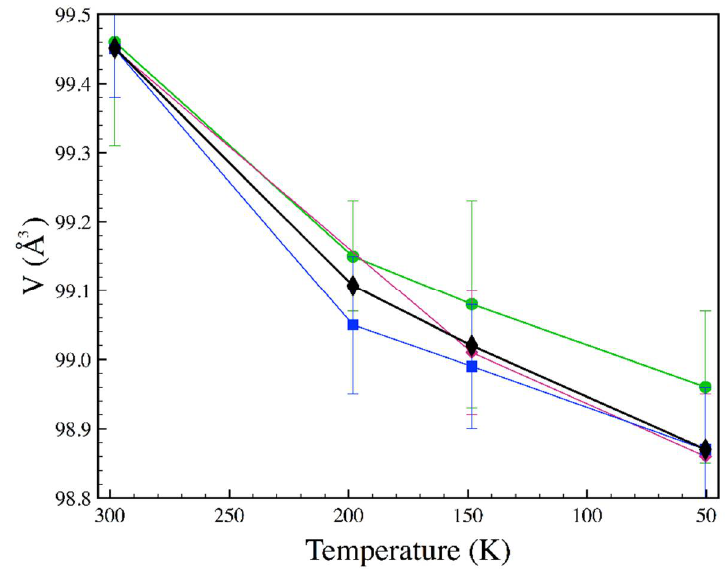
Figure 8. Normalized bond lengths vs temperature at ambient pressure. A representative error bar is shown in black.